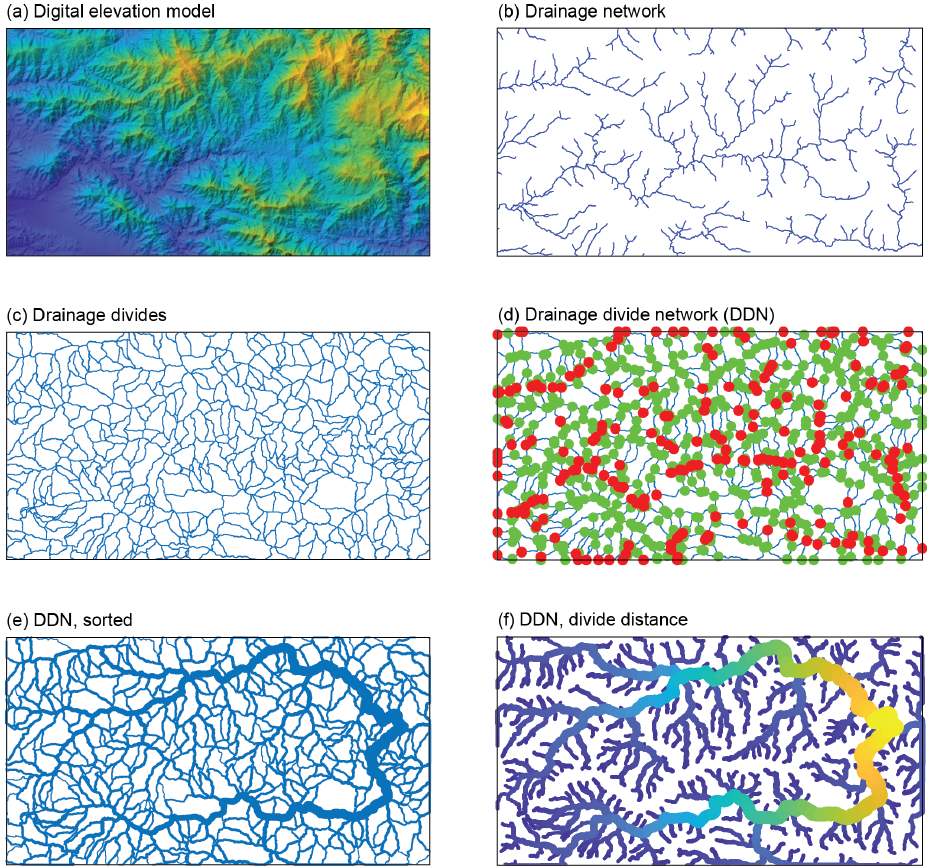
Figure 5. Workflow of identifying and ordering drainage divides in digital elevation models. (a) Digital elevation model of the Big Tu- junga catchment, San Gabriel Mountains, California. (b) Drainage network based on a minimum upstream area of 1000 pixels (0.9km 2 ). (c) Drainage divides of all drainage basins upstream of confluences in panel (b) . (d) Drainage divide network with endpoints (red) and junc- tions (green). (e) Sorted drainage divide network. Line thickness indicates divide order from low (thin) to high (thick). (f) Drainage divide network color-coded by divide distance (blue: low, yellow: high). Note that only divides at a distance > 1km are shown.